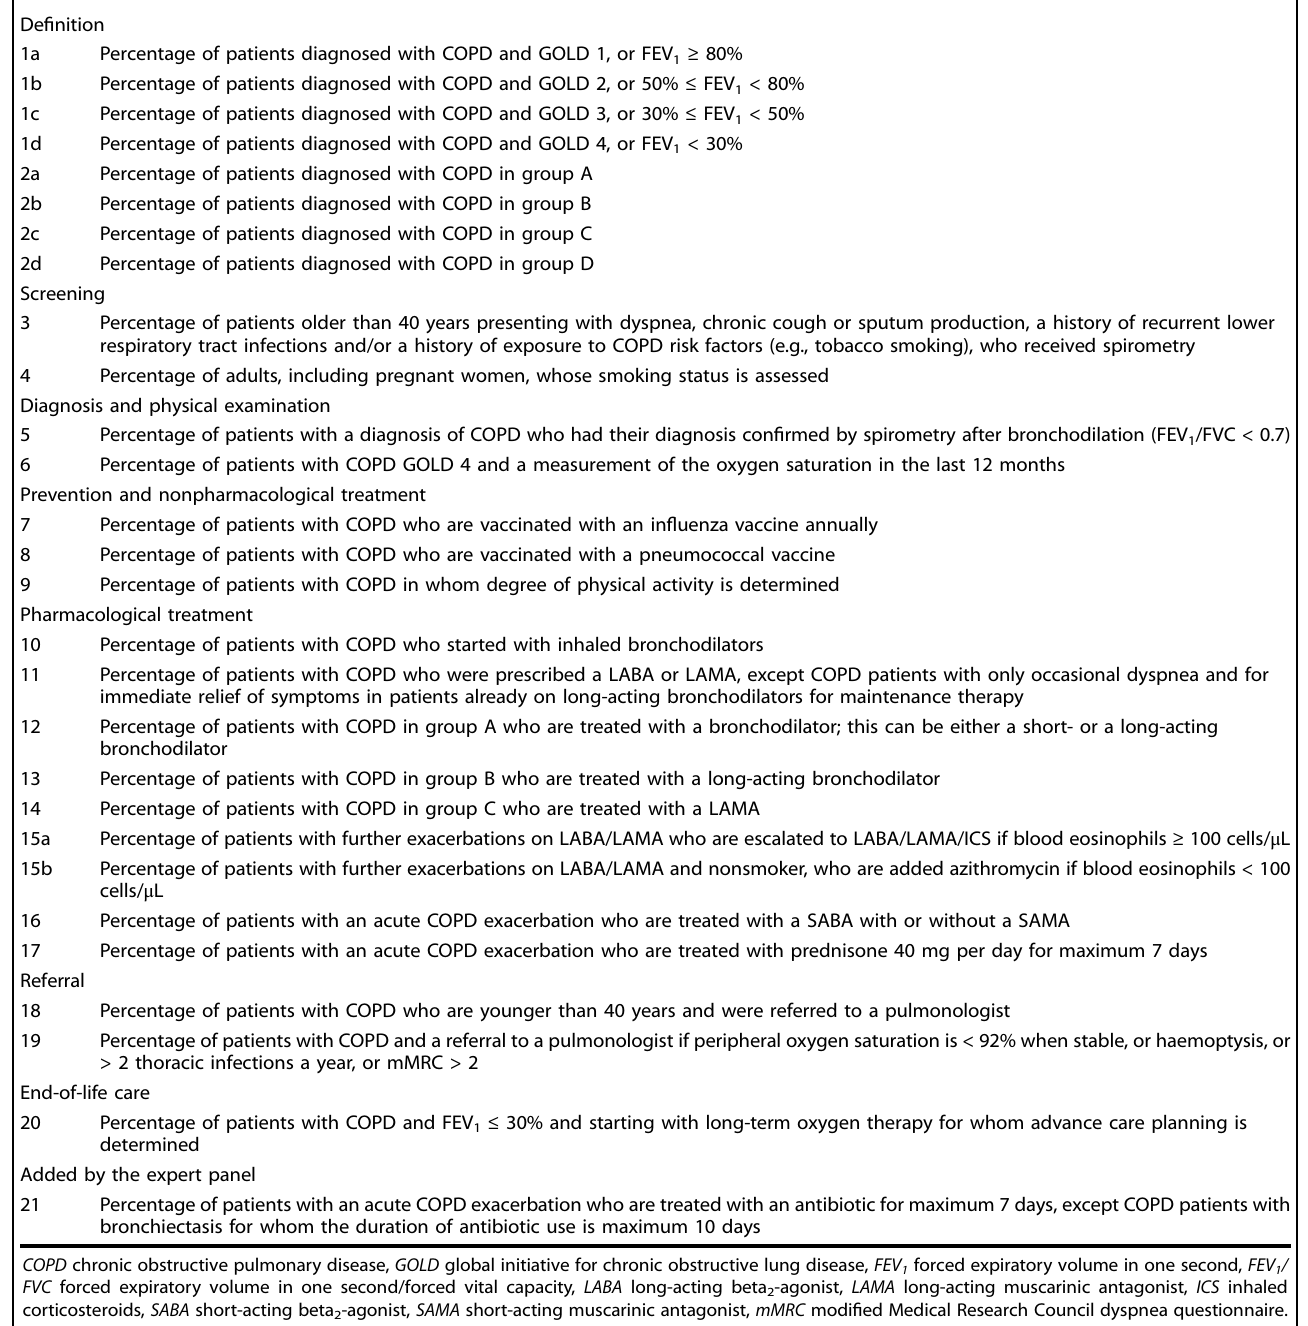
Table 2. Final set of 21 quality indicators (QIs) for COPD.